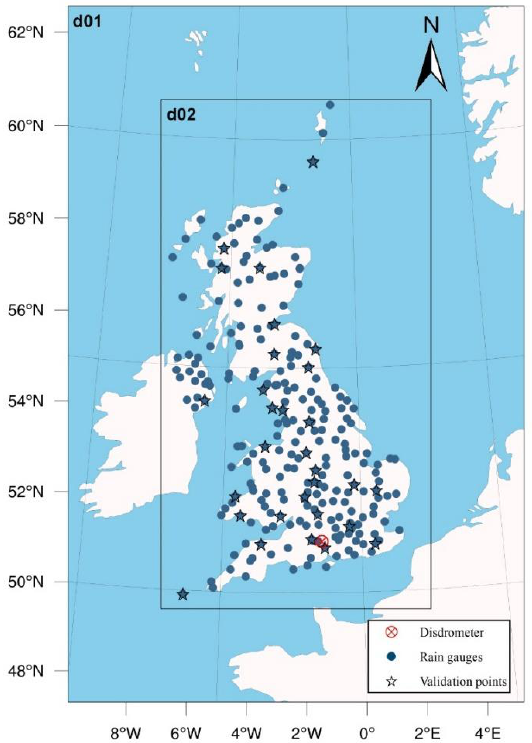
Figure 1. Distributions of the rain gauges and the domain configurations used in the WRF model over the United